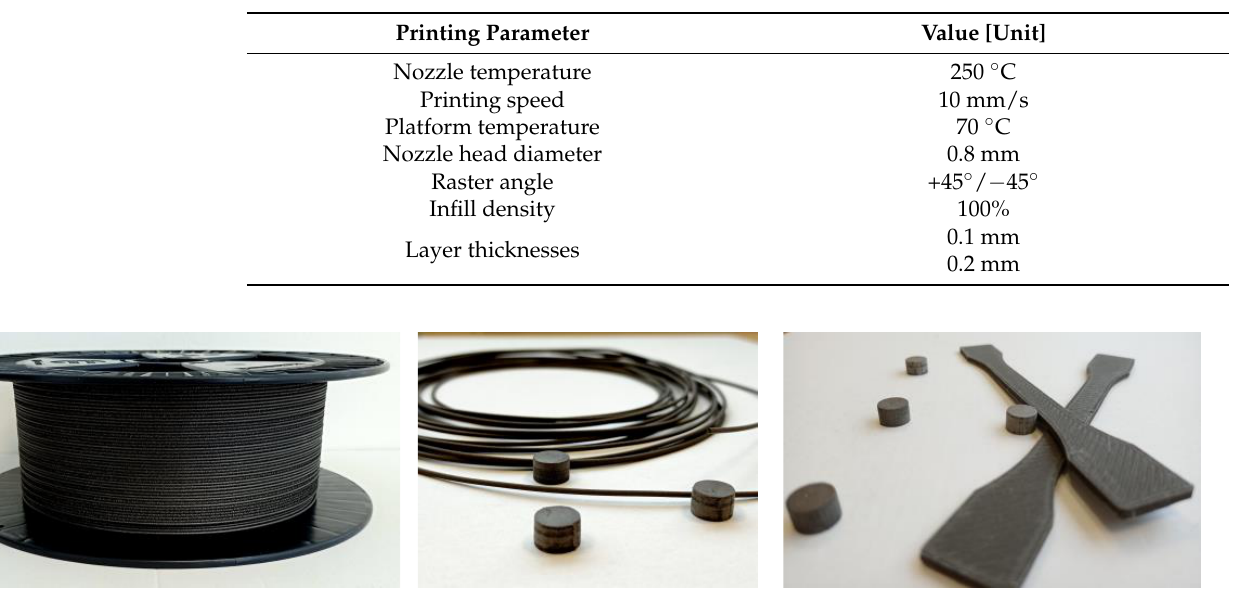
Table 3. Overview of printing parameters.